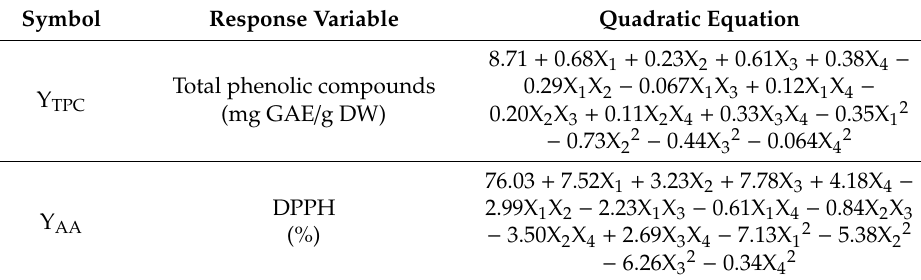
Table 3. Response variables and their fitted model